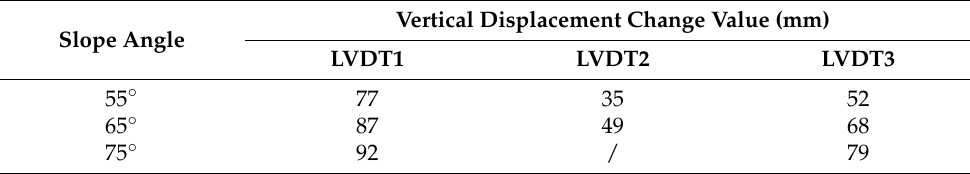
Table 2. Displacement of different monitoring points on each